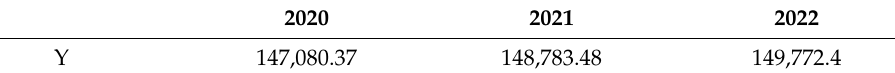
Table 7. The GD’s MIDF for the next three years.